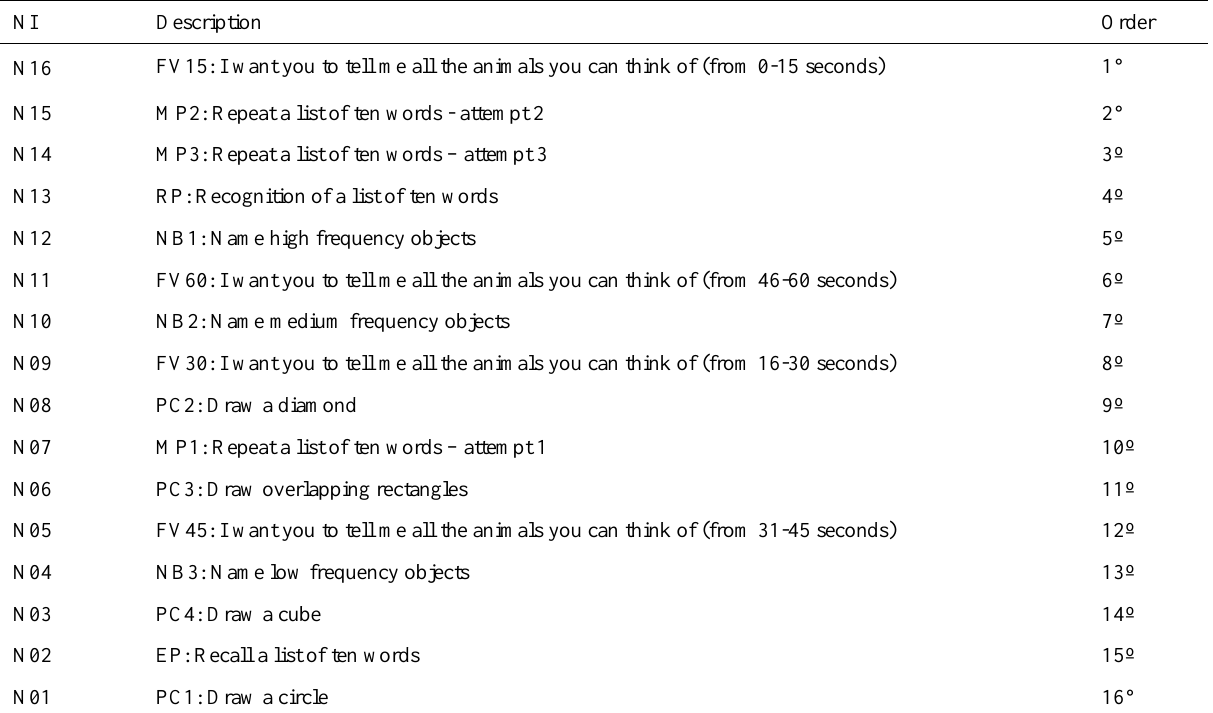
Table 3. Classification of variables in the decision problem